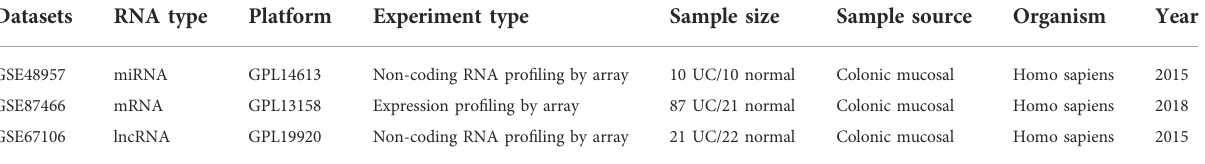
TABLE 1 Basic information of three UC microarray